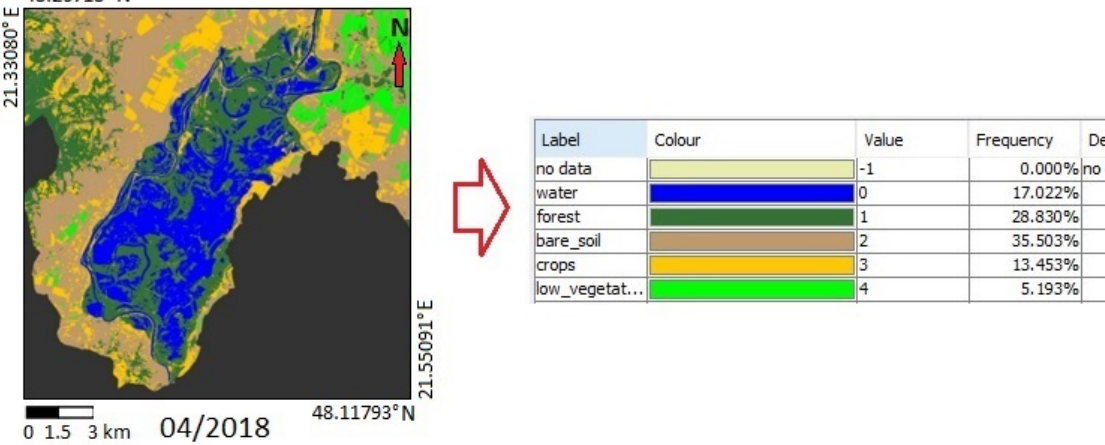
Figure 12. Results of MLC classification show the percentage of pixels in classification classes.